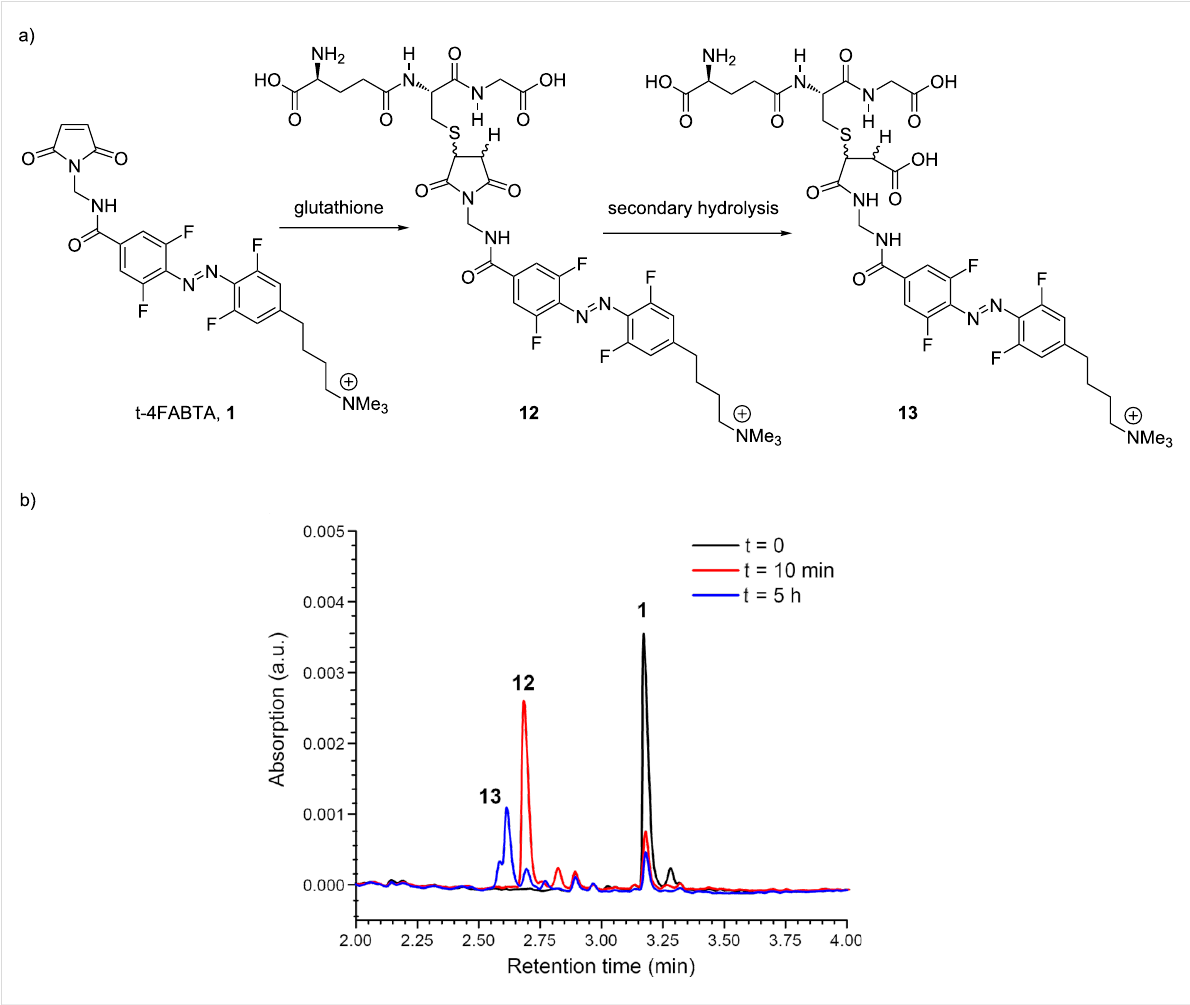
Figure 3: Reaction of t-4FABTA ( 1 ) with thiols, and thermal stability of initial conjugate. a) Chemical reaction of 1 with glutathione in HEPES (pH 7.4) at 37 °C to coupled conjugate 12 , and hydrolysis to 13 . b) UPLC chromatograms of chemical reactions shown in (a). Elution 0.75 to 1 mL/min, 2–100% acetonitrile in water for 4